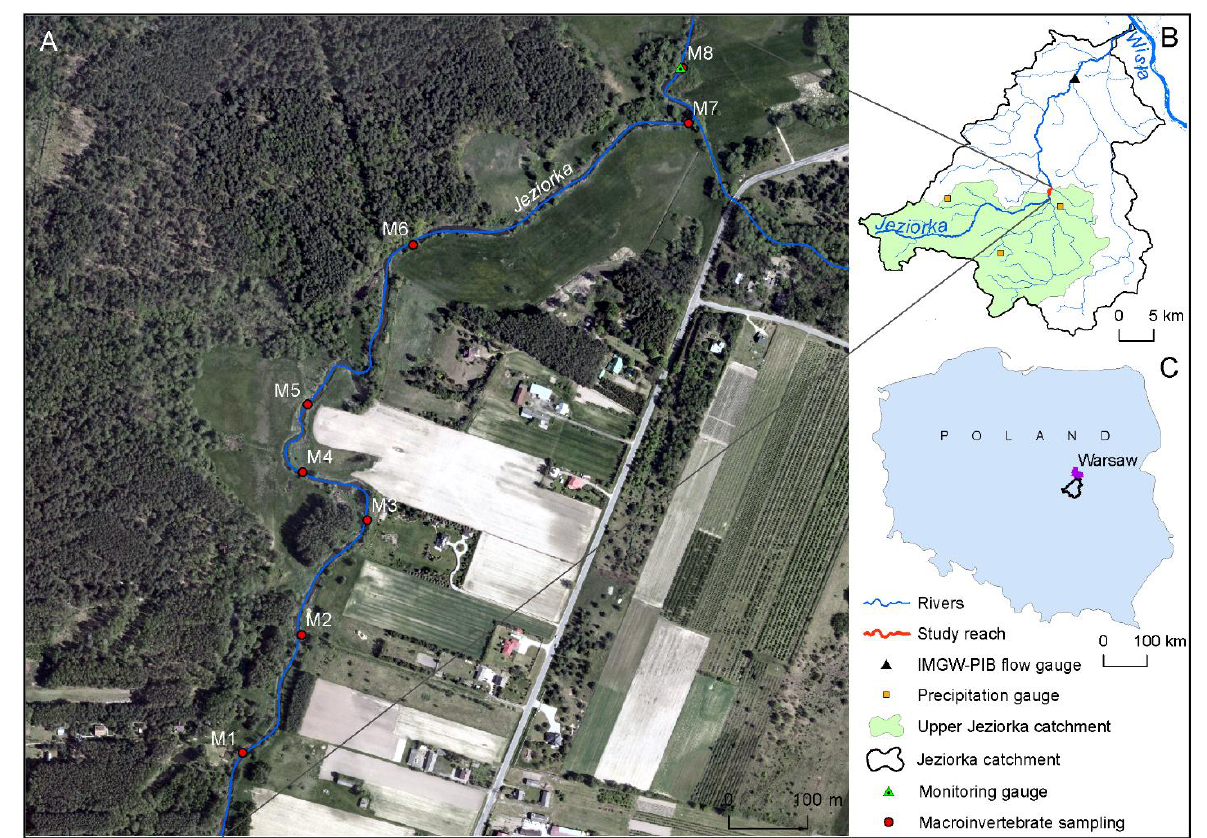
Figure 1. Study area: ( A ) selected reach of the Jeziorka River with eight benthic macroinvertebrate (BM) sampling sites and a flow and water quality monitoring gauge against an orthophoto map; ( B ) location of the reach within the Jeziorka catchment; ( C ) location of the Jeziorka catchment in Poland.